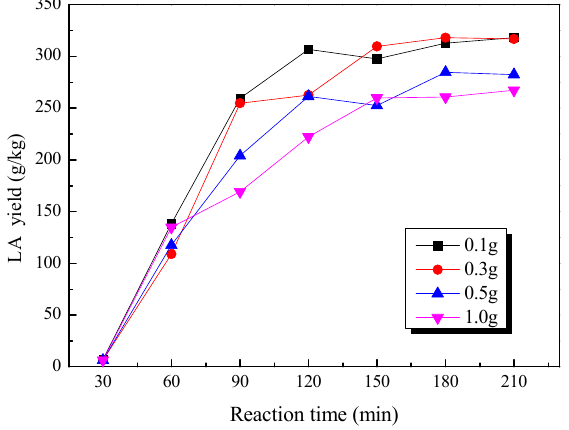
Figure 5. Effect of substrate loading amount on LA production from cow dung (reaction conditions: 0.4 M HCl aqueous solution 10 mL, 180 °C).